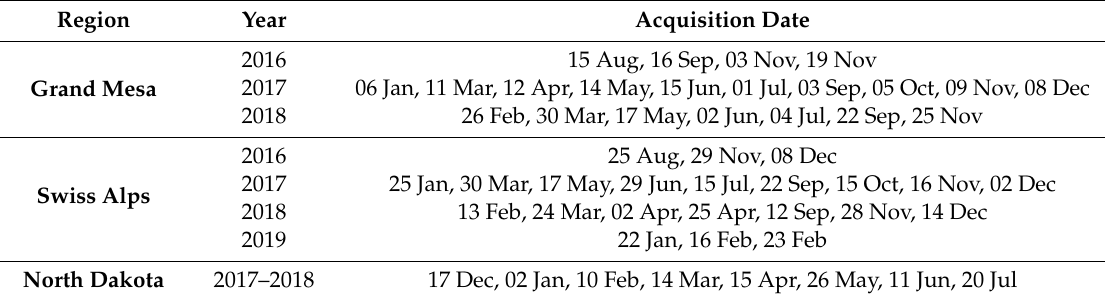
Table 4. Landsat-8 data